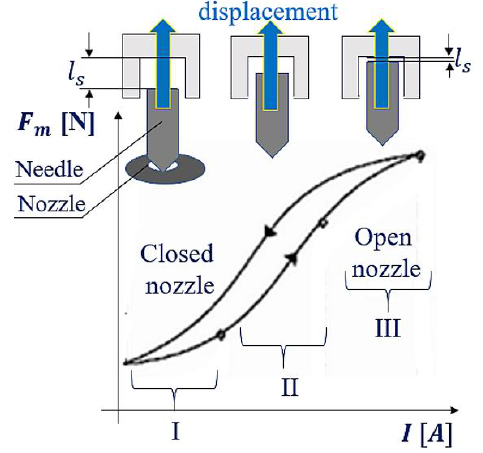
Figure 4. Relationship between magnetic force 𝐹 𝑚 and the size of gap 𝑙 𝑆 . These are two cases, A and B.